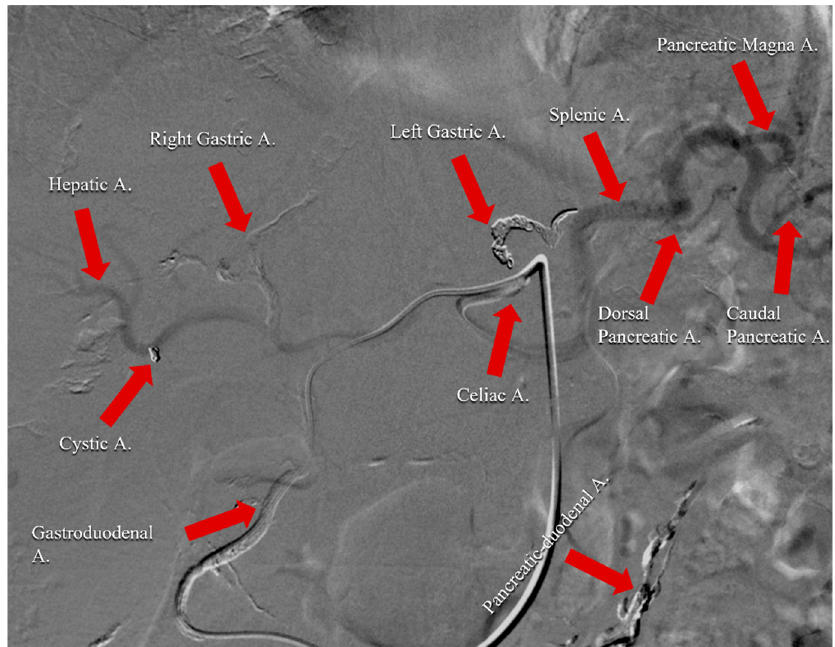
Figure 1. ( A ) Angiographic scan representing the vascular anatomy of celiac artery. ( B ) Angiographic scan representing vascular anatomy of superior mesenteric artery.